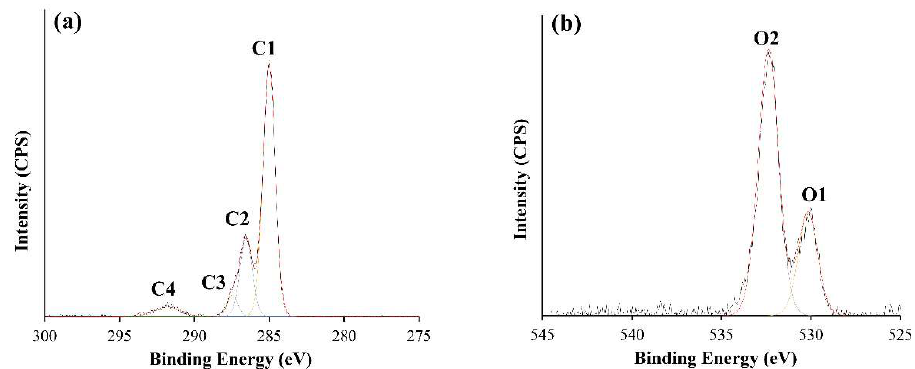
Figure 4. High-resolution peak fitted XPS spectra for as-received PEEK. ( a ) C 1 s and ( b ) O 1 s .